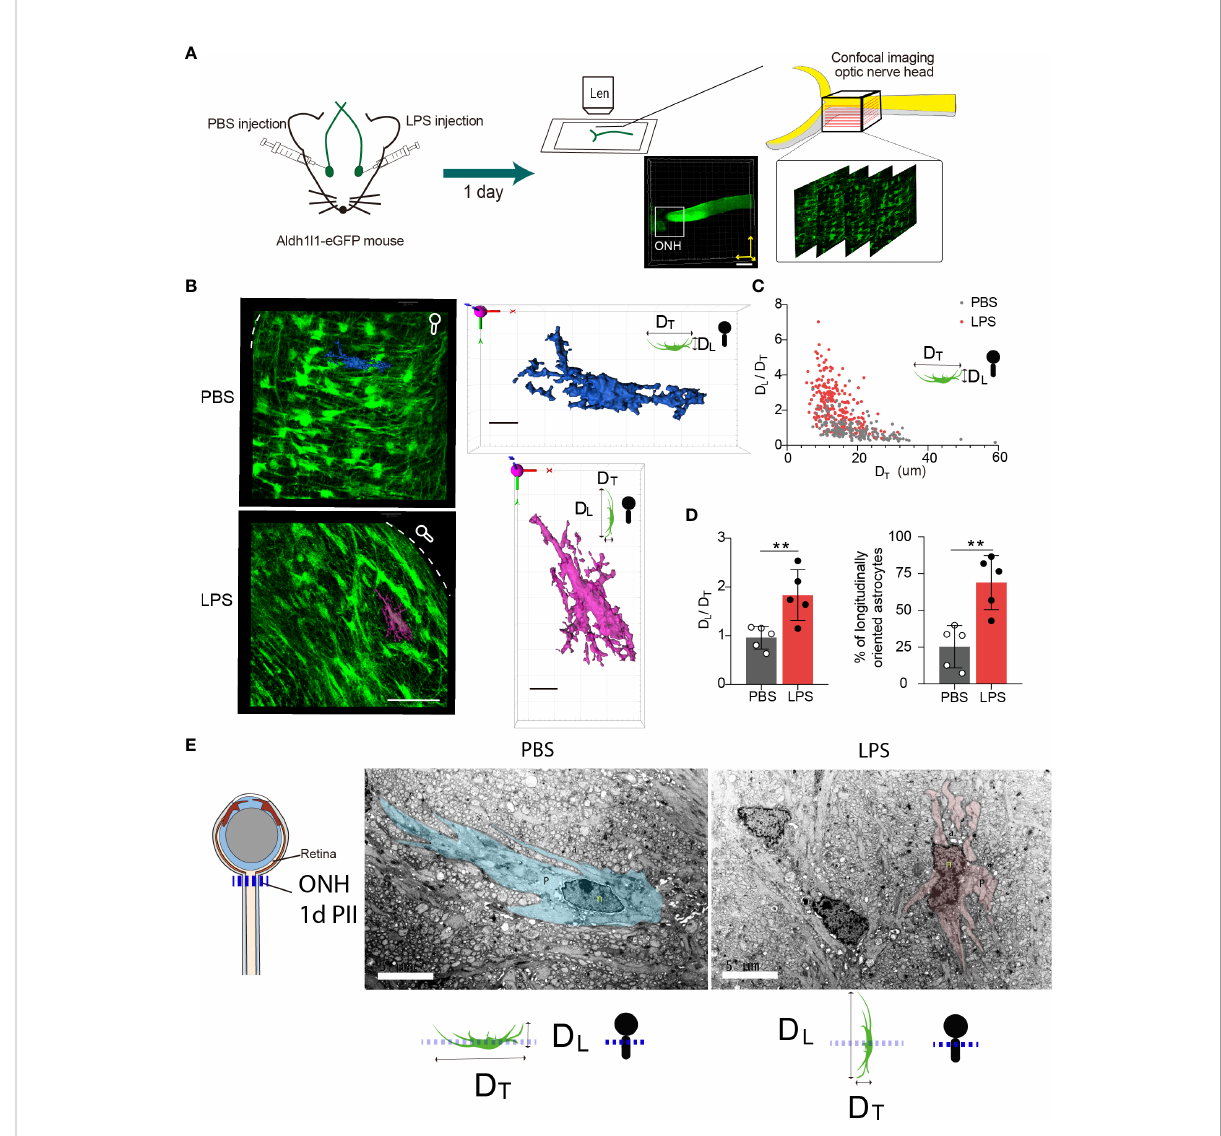
FIGURE 4 Intravitreal LPS injection triggers signi fi cant morphological transformation in the ONH astrocytes on day 1 PII. (A) Schematic illustration of the experiment procedure for confocal imaging in the fi xed tissue sample of the ONH generated from Aldh1L1-eGFP reporter mice. (B) Representative images generated from z-projection of xy-z confocal imaging stacks in the ONH for both groups. Scale bar, 50 m m. Circle- rod shape in white at the upper right simulates the orientation of the retina and ON. Color-code 3D-construct cell surfaces exemplify the morphological features of ONH astrocytes in both groups; scale bar, 10 m m, DT indicates the diameter of the cell domain along the coronal axis of the ONH; DL indicates the diameter of cell domain along the longitudinal axis of the ONH. (C) Distribution of the ratio of DL/DT plotted against the DT (unit, m m) for both groups; n = 177 cells for the PBS group, and n =245 cells for the LPS group. (D) Statistical comparisons of the ratio of DT/DL, the fraction of longitudinally oriented astrocytes between the PBS and LPS groups; n = 5 ONs per group. (E) Transmission electron microscopic imaging of rat ONH astrocyte on day 1 PII of PBS and LPS. The representative astrocyte morphology was outlined by pseudo color (PBS, blue) and (LPS, pink). Scale bar, 5 m m. All data are presented as the mean ± SD. Unpaired t-test was performed for statistical analysis, **P <